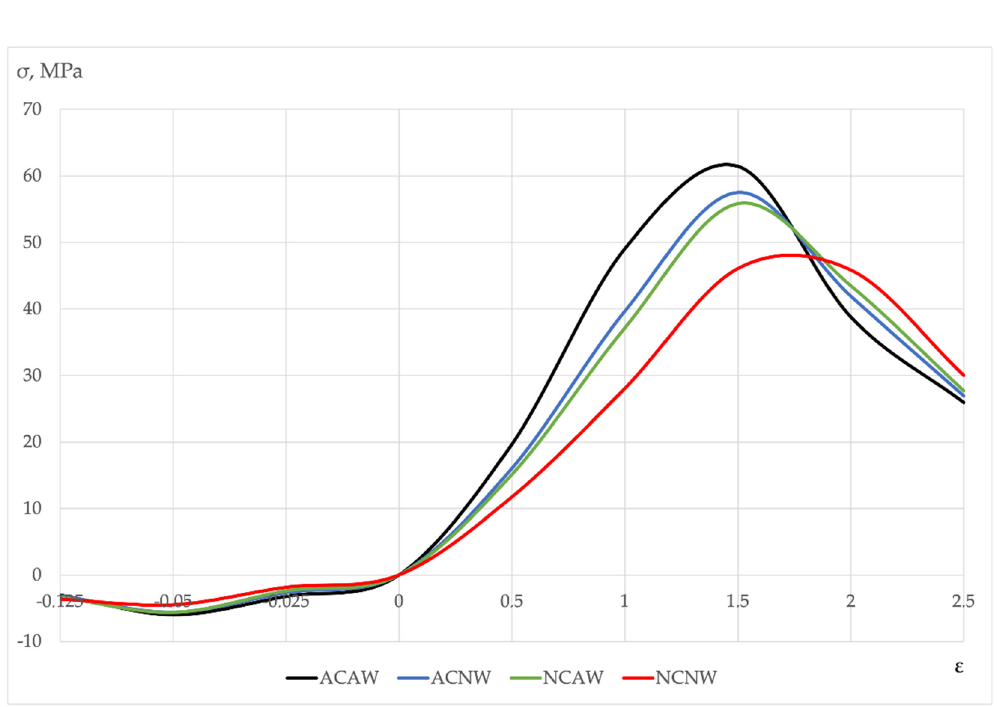
Figure 13. Relationship between concrete deformation diagrams and manufacturing technology.